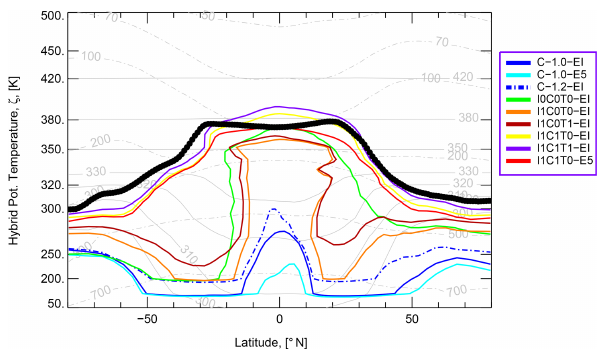
Figure 3. Like in Fig. 2 but only the 90ppbv isoline of the e90 tracer is color-coded for runs listed in Table 2. Thick solid black line denotes the WMO